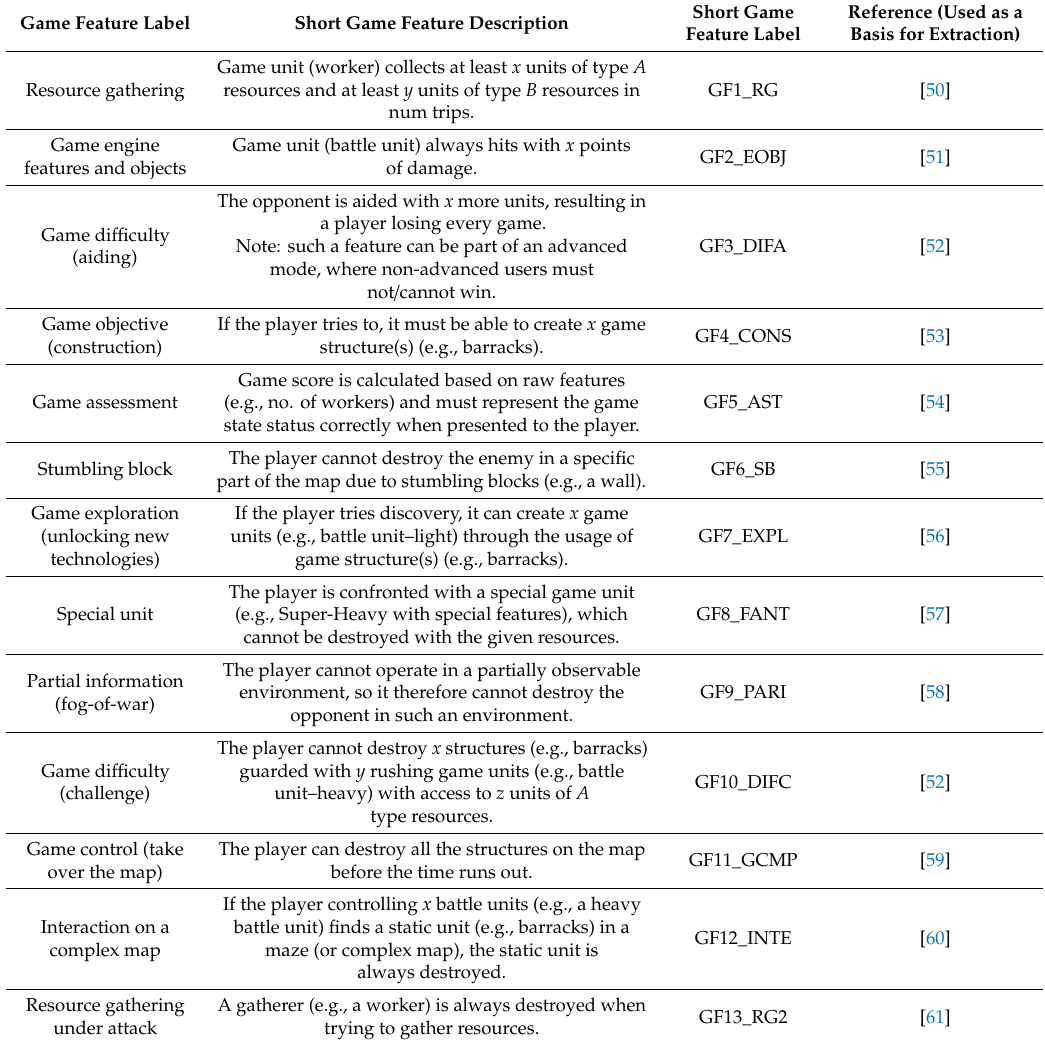
Table 1. Game feature descriptions derived from related